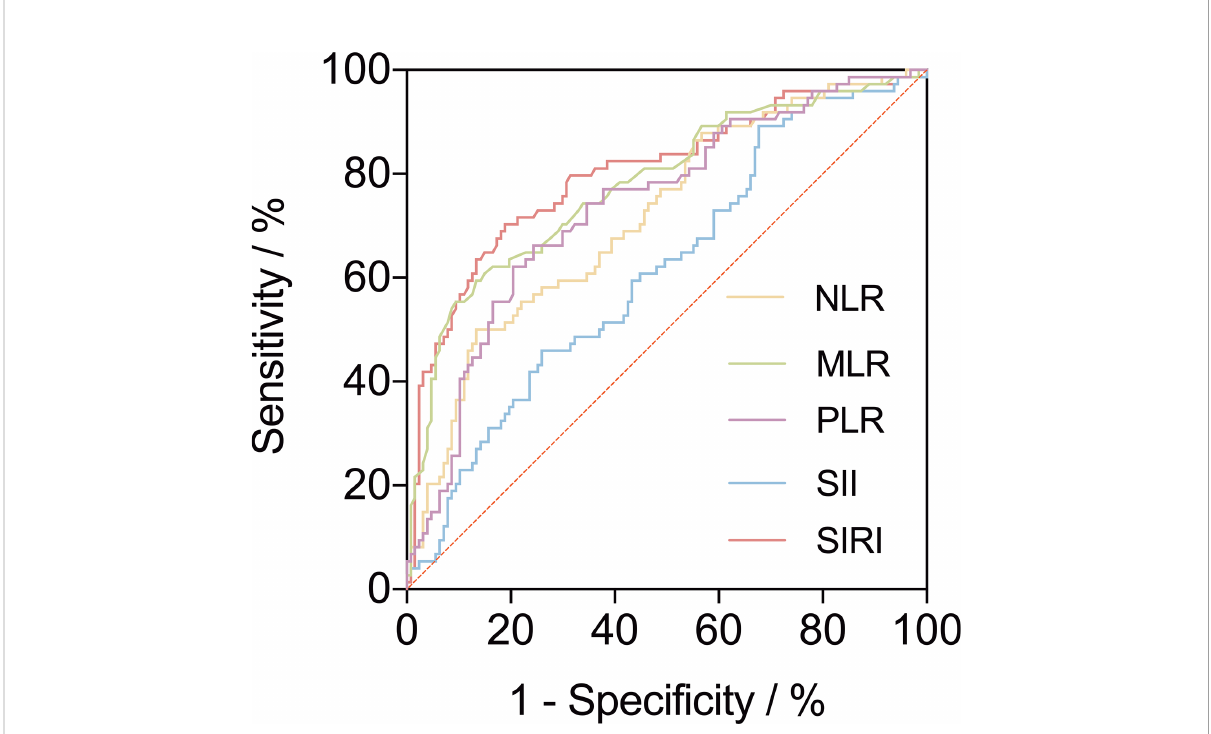
FIGURE 2 A receiver operating characteristic curve (ROC) to explore the value of pre-operative in fl ammatory biomarkers to identify aorta-related adverse events (AAEs) after thoracic endovascular repair. The area under the ROC curve of neutrophil-to-lymphocyte ratio, monocyte-to-lymphocyte ratio, platelet-to-lymphocyte ratio, systemic immune in fl ammation index and systemic in fl ammatory response index were 0.746, 0.782, 0.534, 0.625, and 0.807,